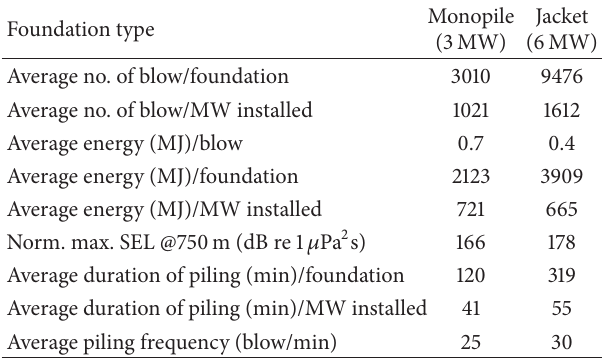
Table 3: Normalized @ 750 m zero to peak sound pressure level ) in dB re 1 𝜇 Pa. Normalized @ 750 m mean and maximum ( 𝐿 𝑧 – 𝑝 sound exposure levels (SEL) in dB re 1 𝜇 Pa 2 s.